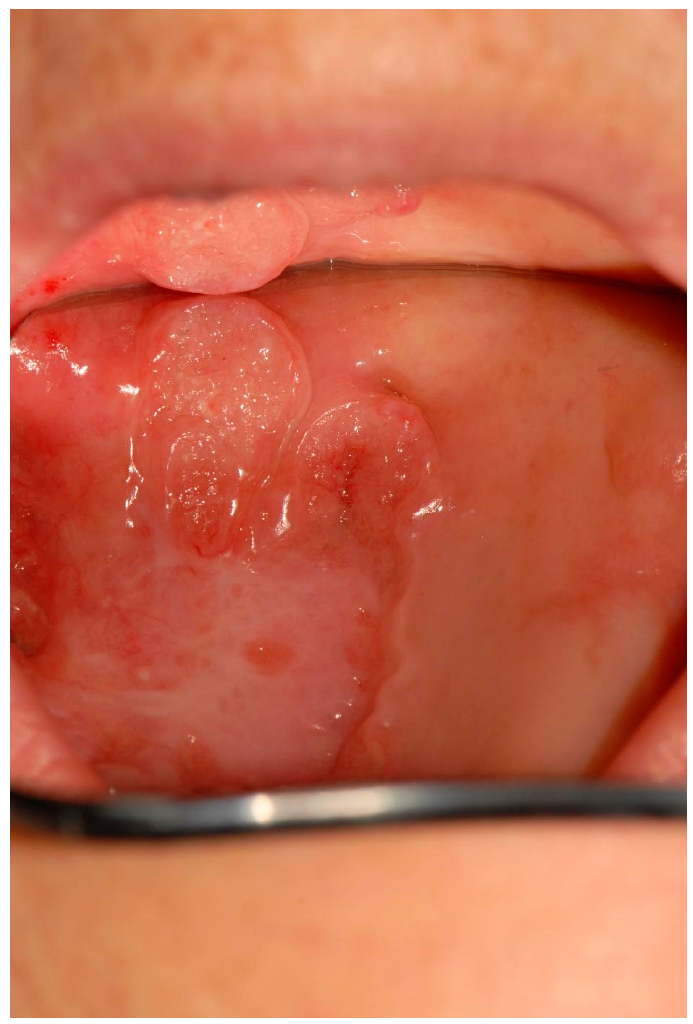
Figure 6. Ulcerative area of the palate (Patient no. 10, Table 2).